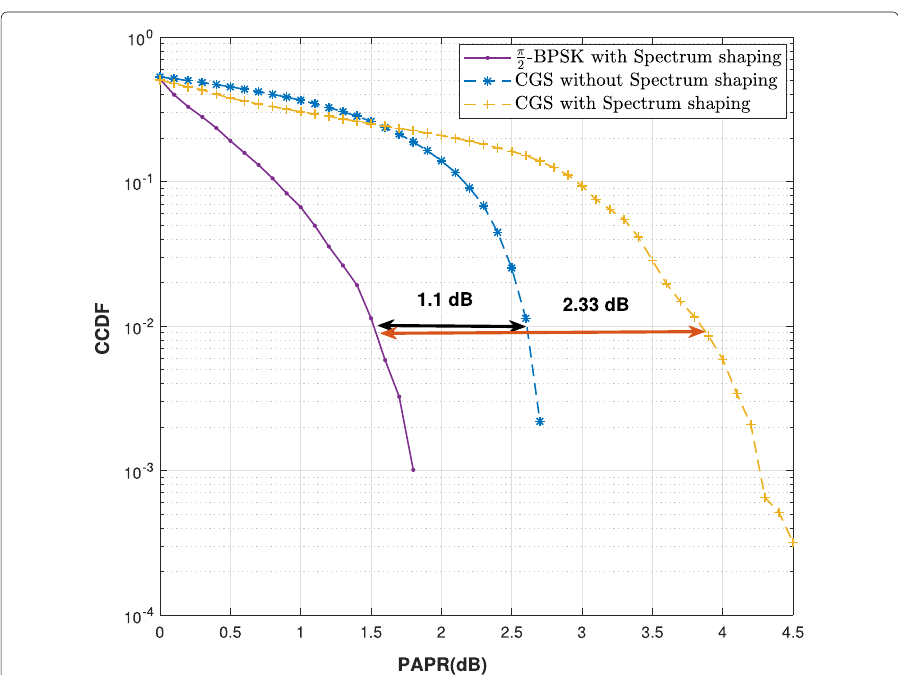
Fig. 15 PAPR of length-12 3GPP CGS and π/ 2-BPSK DMRS